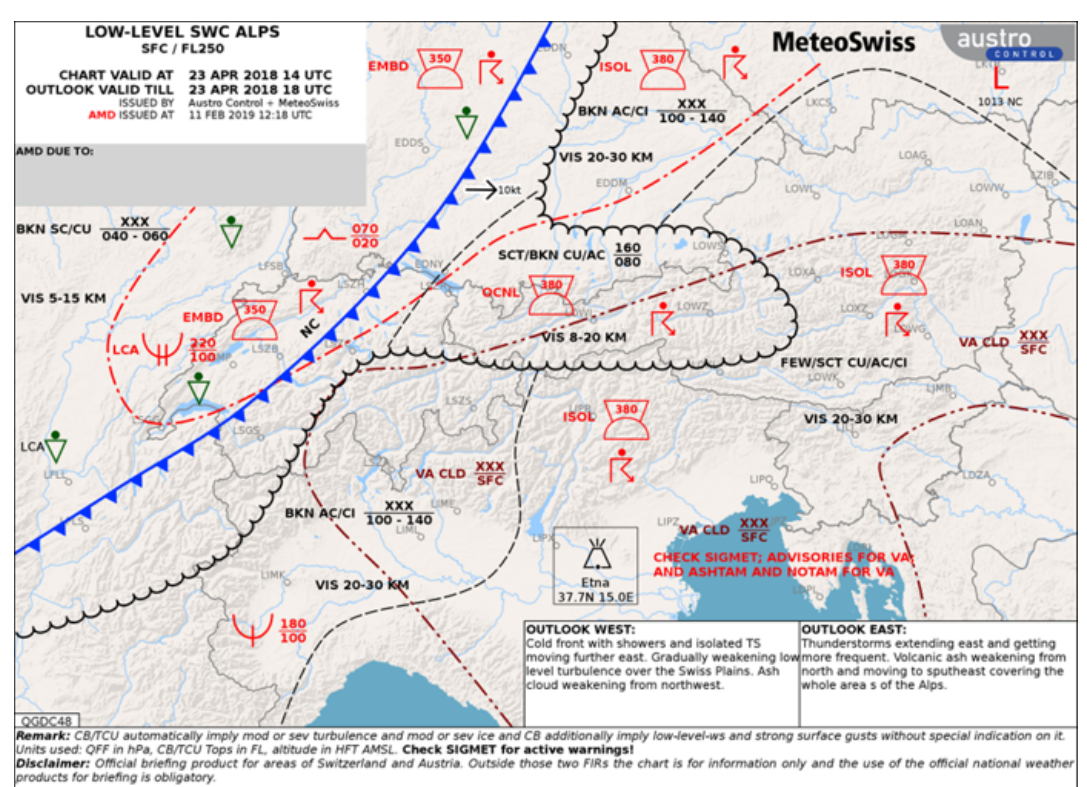
Figure 12. Low-level significant weather chart for 23 April 14:00UTC. The predicted volcanic ash is represented by the brown dash-dot- dotted line over the Adriatic Sea, parts of Italy and Slovenia, south-eastern Switzerland, and the southern half of Austria and Hungary and extends from the surface to over